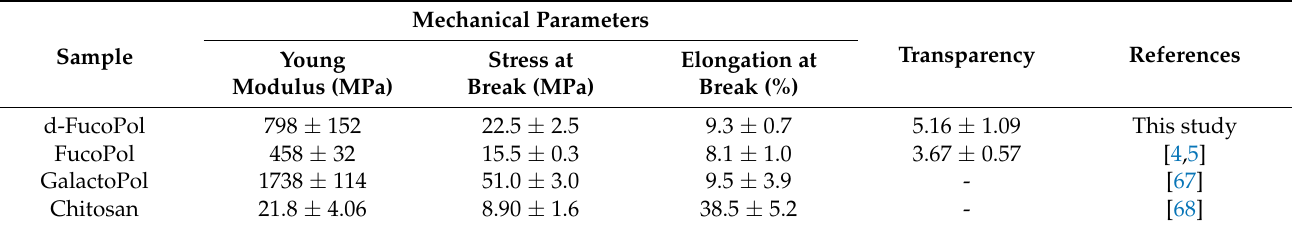
Table 5. Mechanical parameters and transparency of the films prepared with d-FucoPol, FucoPol, and other biopolymers. Data are shown as the average ± standard deviation (SD) (n = 4).